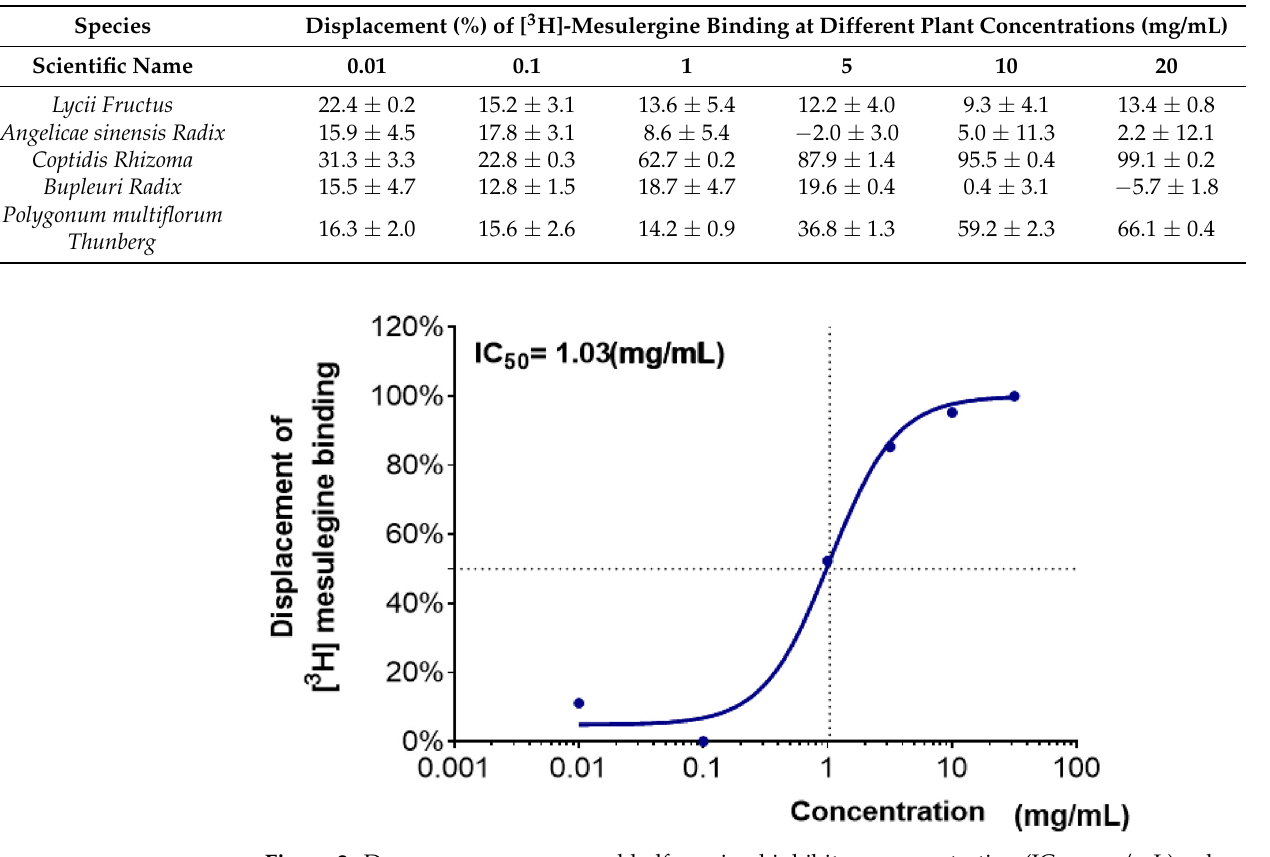
Table 2. Displacement of the [ 3 H]-mesulergine binding of water extracts of medicinal plants to the membrane expressing the human 5-HT 2C receptor.